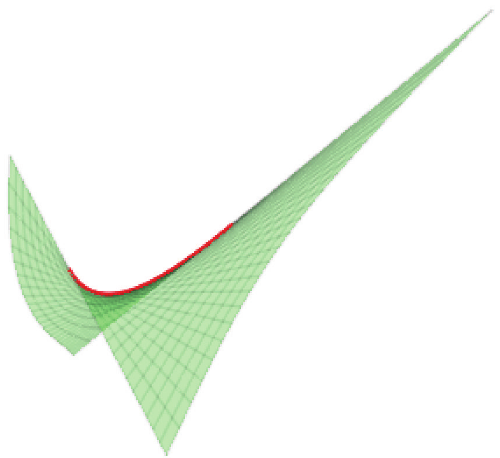
𝑥 𝑥 2 3 4 -space.